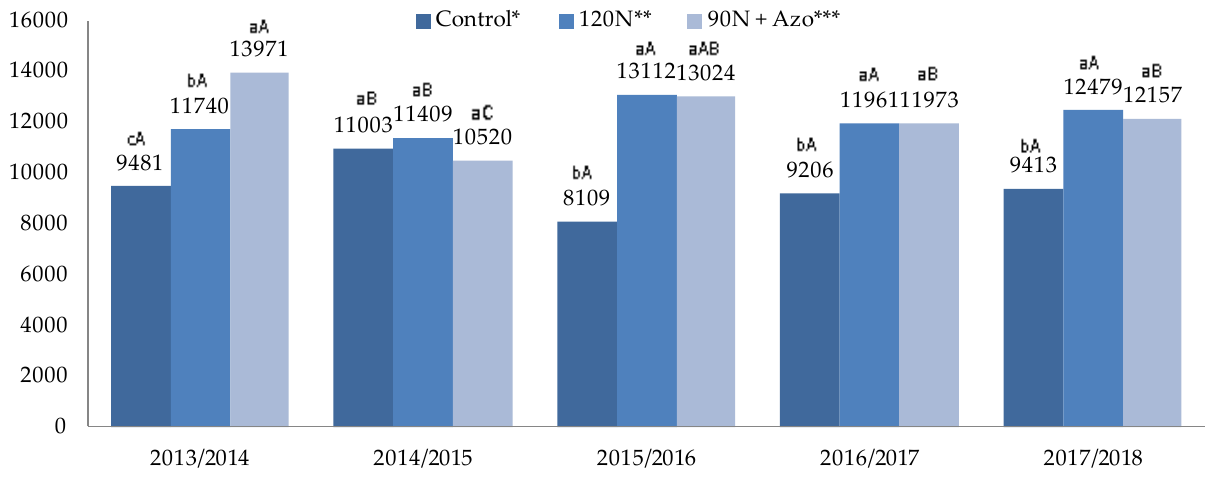
Figure 1. Mean yields of rice grains (kg ha − 1 ) 1 , over the 5-year period of the 2013/14 to 2017/18 agricultural seasons, as a function of inoculation with Azospirillum brasilense (strains Ab-V5 and Ab-V6). Data represent the means of five repeat field experiments, each with four replicates. When followed by the same letter, lowercase (compare treatments) and capital letters (compare crops) do not differ significantly from each other according to the Tukey test in p ≤ 0.05. 1 coefficient of variation = 14.8%. * Absence of N and inoculant. ** 120 kg of N ha − 1 . *** 90 kg of N ha − 1 + Azospirillum brasilense . The shades of the vertical bars indicate the treatments: dark blue (control, noninoculated); blue (complete nitrogen fertilization); light blue (seed inoculation with Azospirillum brasilense and reduced nitrogen